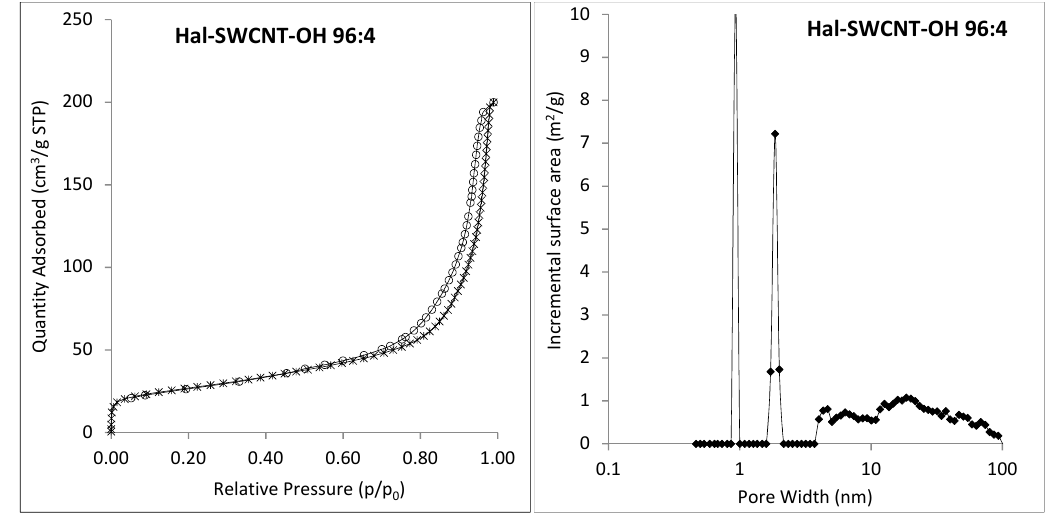
Figure 5. Nitrogen sorption-desorption isotherms ( left ) and pore size distribution ( right ) of the Hal, SWCNT, SWCNT-OH, Hal-350, Hal-450, Hal-550 and Hal-CNT composites.